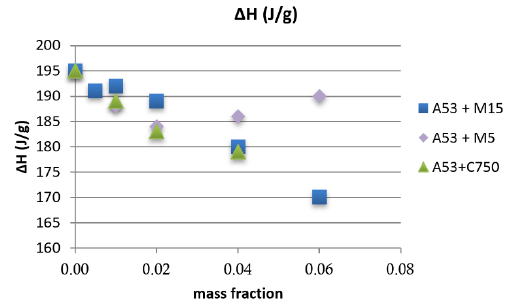
Figure 5. Heat of fusion as a function of mass fraction of: squares, M15 (diameter = 15 µ m, thickness = 6–8 nm, and surface area = 120–150 m 2 /g); rhombuses, M5 (diameter = 5 µ m, thick- ness = 6–8 nm, and surface area = 120–150 m 2 /g), and triangles, C750 (diameter < 2 µ m, thickness = a few nm, and surface area = 750 m 2